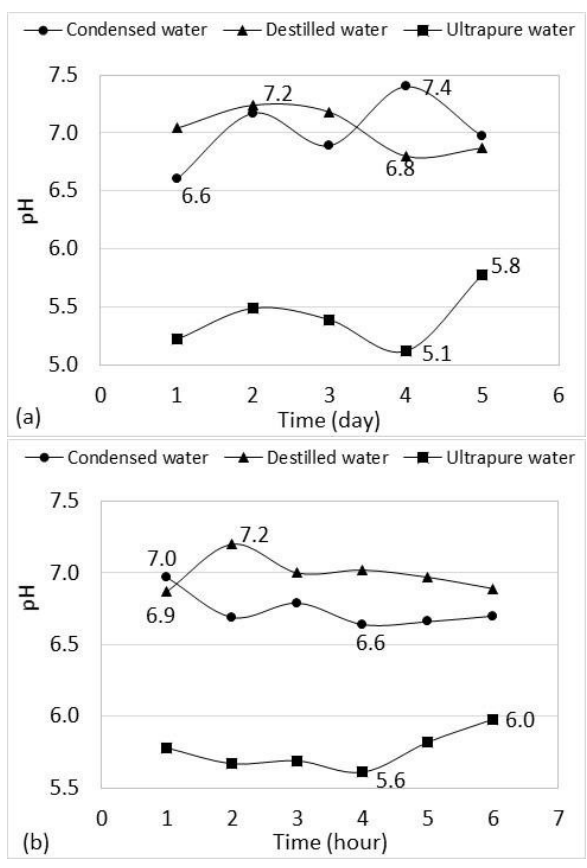
Figure 4: pH values found in condensed, distilled and ultrapure water, with daily (a) and hourly (b)